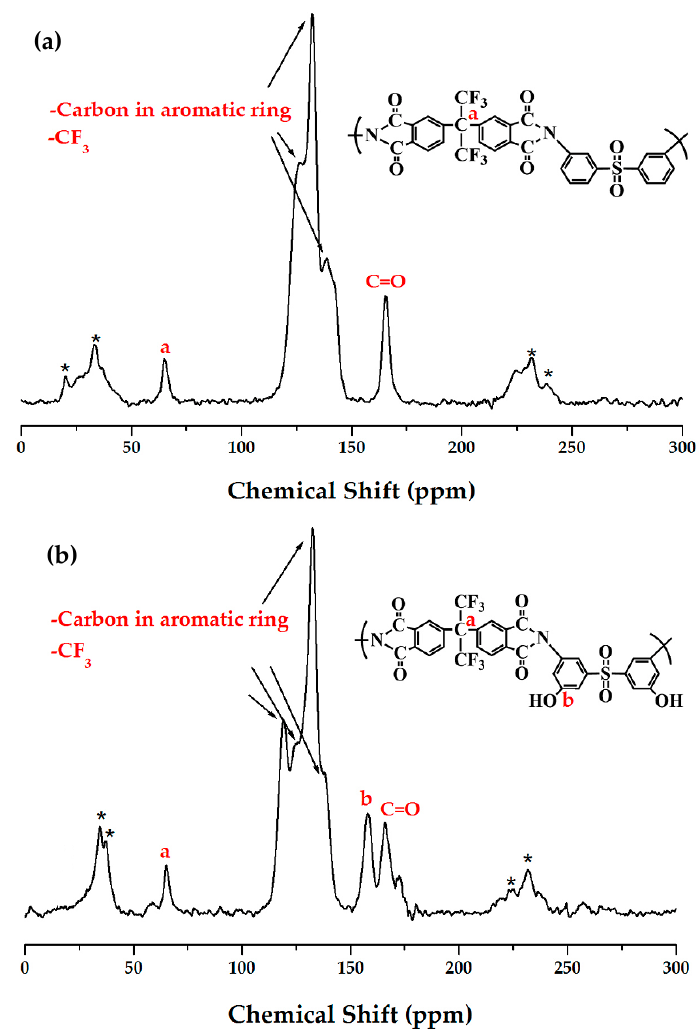
Figure 3. 13 C-NMR chemical shifts of ( a ) BAS and ( b ) BAS-OH polymers at room temperature. The spinning sidebands are marked with asterisks.